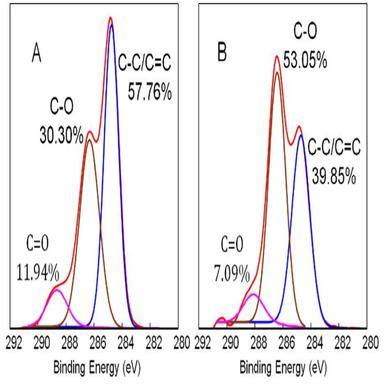
XPS spectra of (a) GO and (b) GO after reaction with 200 mg/L free chlorine at pH 5 under UV irradiation (2000 µW/cm2 ) for 2 h.